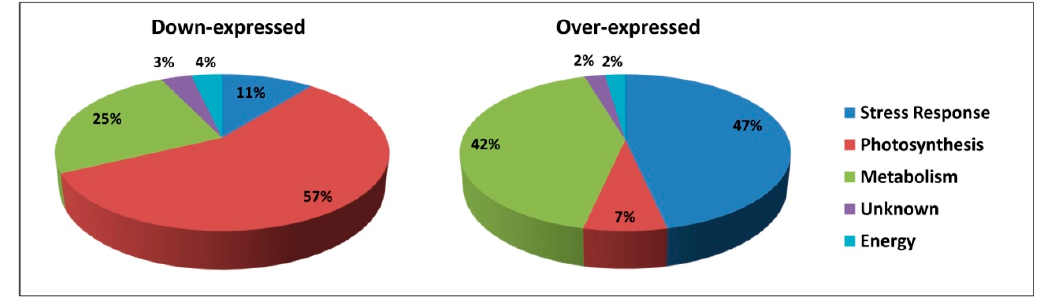
Figure 4. Pie-representation of differentially expressed proteins. The functional category distribution of the 54 identified proteins in Arabidopsis leaves subjected CP treatments. Data about the sub-cellular localization and biological function of each identified protein are available on Tables 1 and 2.